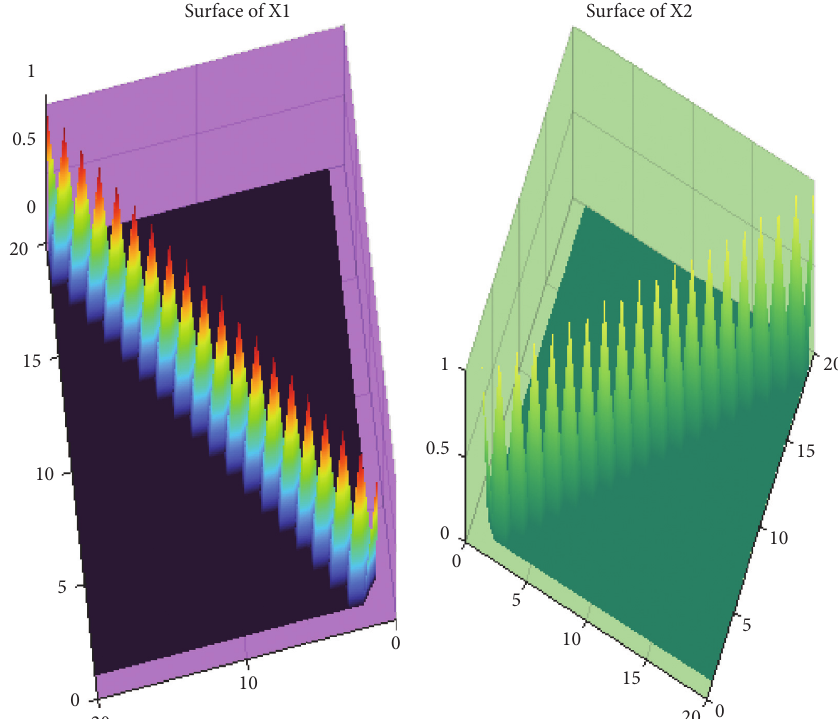
Figure 19: Solution surface plot for dimension